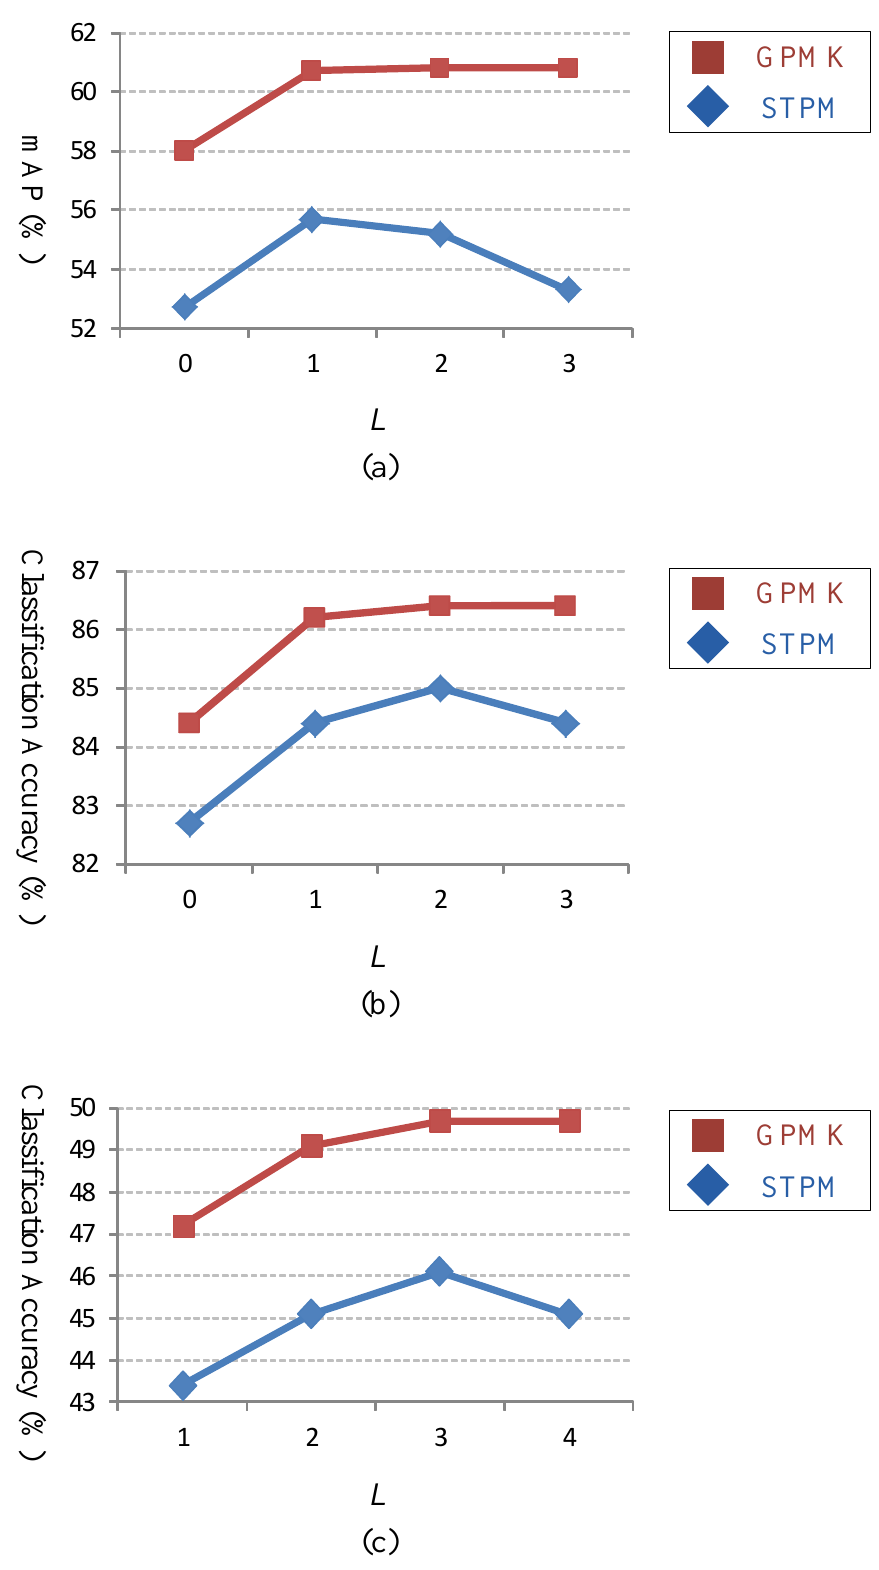
Figure 5. The recognition performance (shown on the Y-axis) w.r.t. different values of L (shown on the X-axis): ( a ) Hollywood2; ( b ) Youtube; ( c ) HMDB51. In each panel, the red square markers correspond to our generalized pyramid matching kernel (GPMK), and the blue diamond ones represent the spatial-temporal pyramid matching (STPM) kernel for